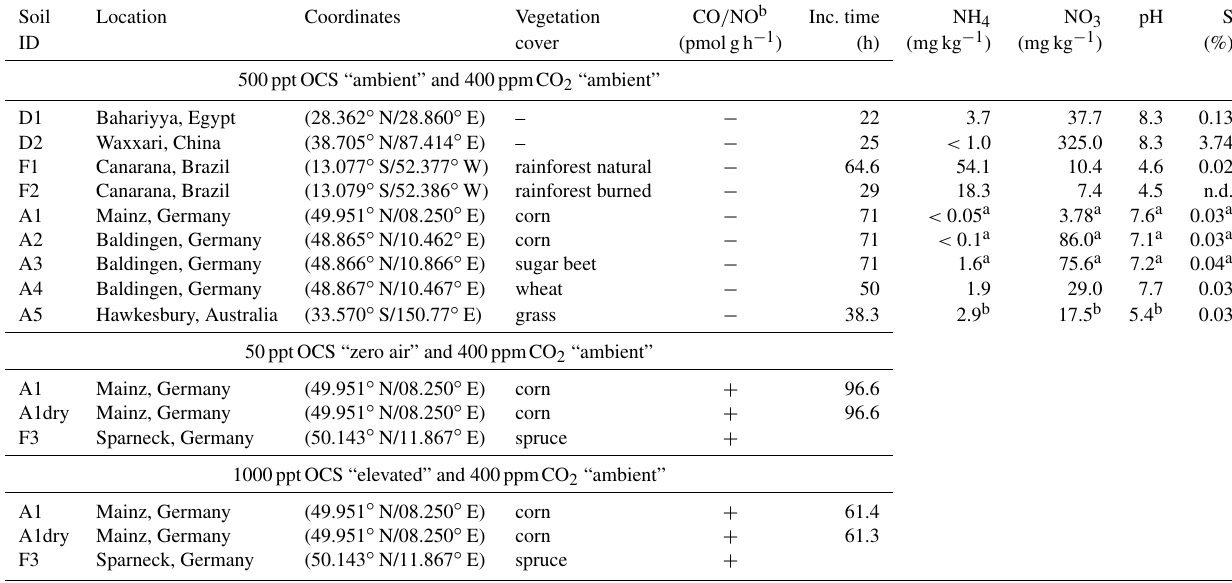
Table 1. Soil properties and experimental conditions used for analysis. Note that NO and CO exchange rates were measured only for A1, A1dry, and F3 soils at 50 and 1000pptOCS, respectively. Temperature for all experiments was 25 ◦ C. Soil